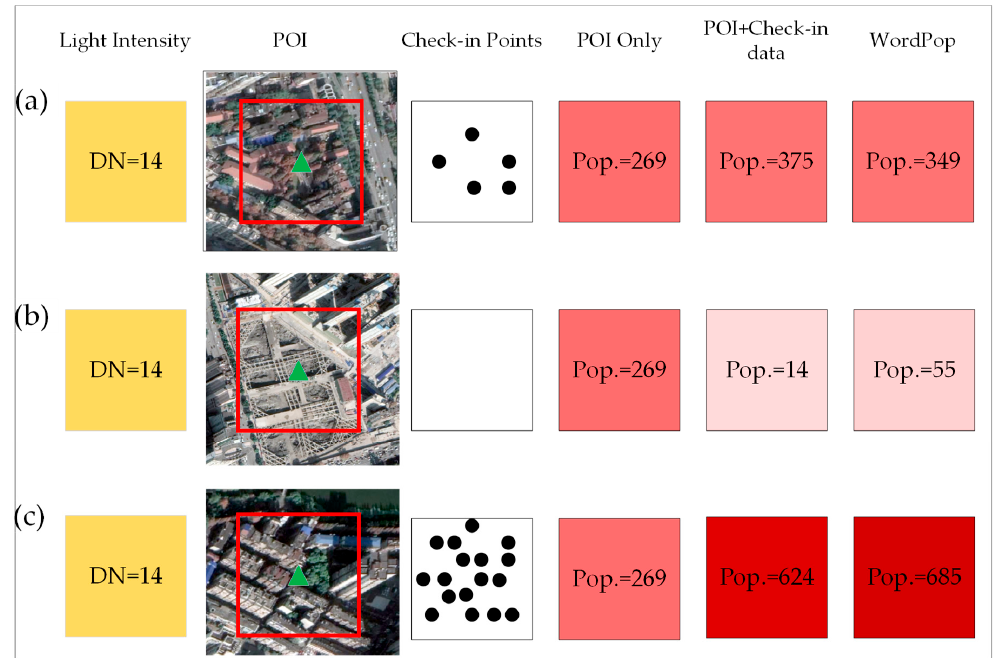
Figure 10. Comparison of estimated results before and after adopting the check-in data with three sample residential regions (region a , b and c ) having the same light intensity.